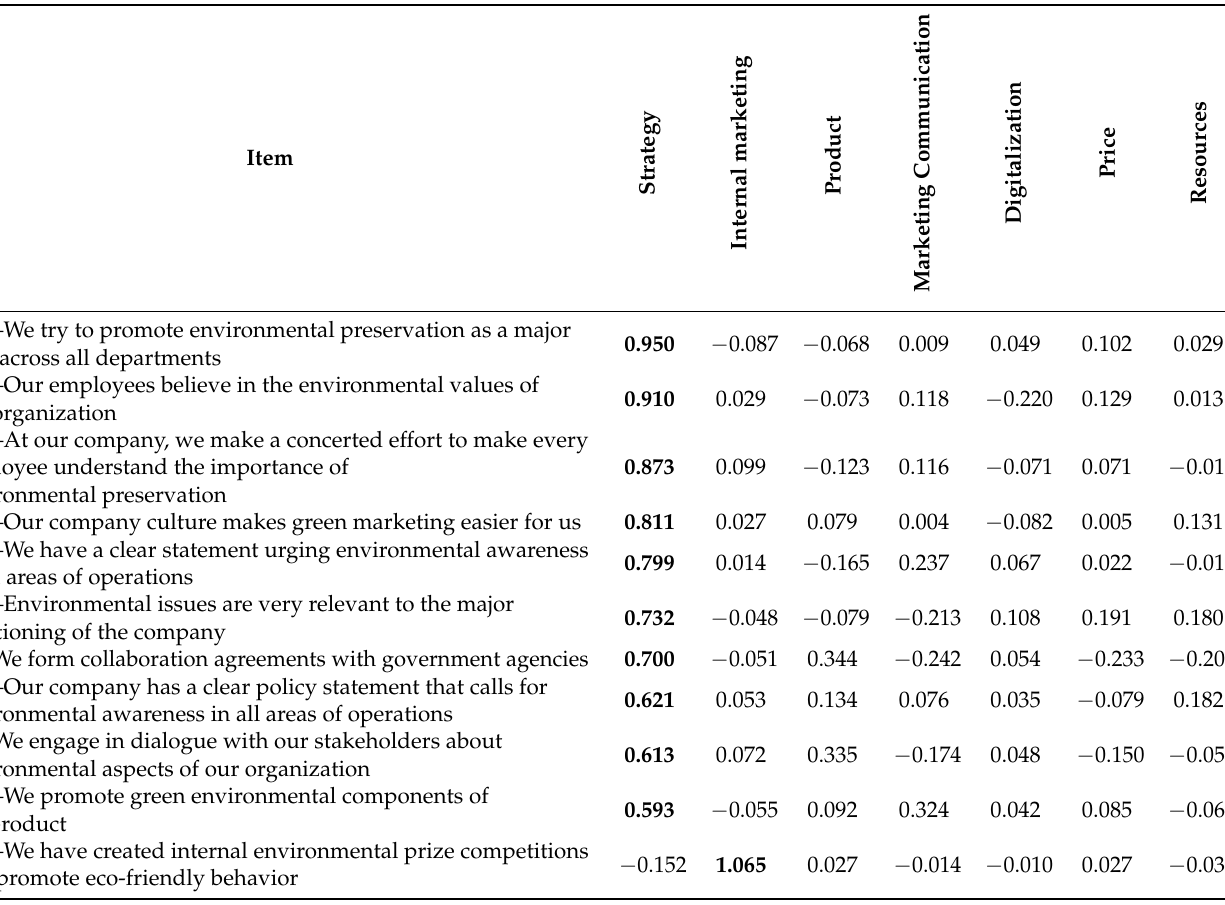
Table 3. Results of the exploratory factor analysis (EFA) for the retained Green Marketing Scale (GMaS) items (Study